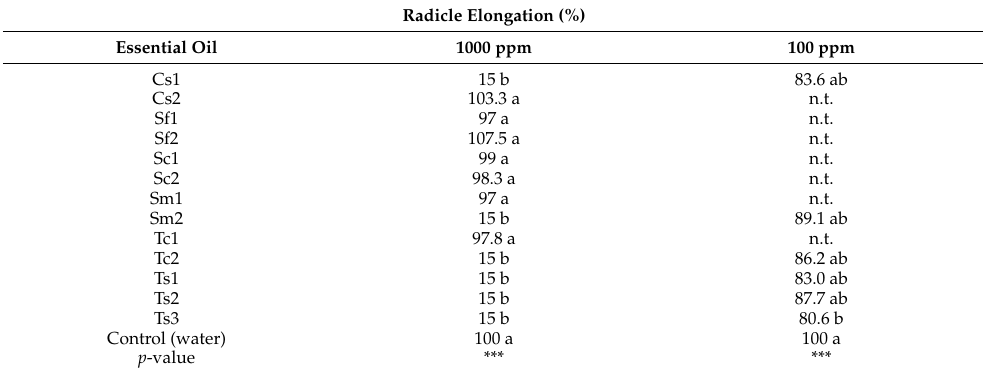
Table 4. Effect of two doses of EOs on radicle elongation of Solanum lycopersicum var. Marmande after 3 days of incubation. Data are expressed as mean of three replicates of 10 seedlings each, in comparison with the control